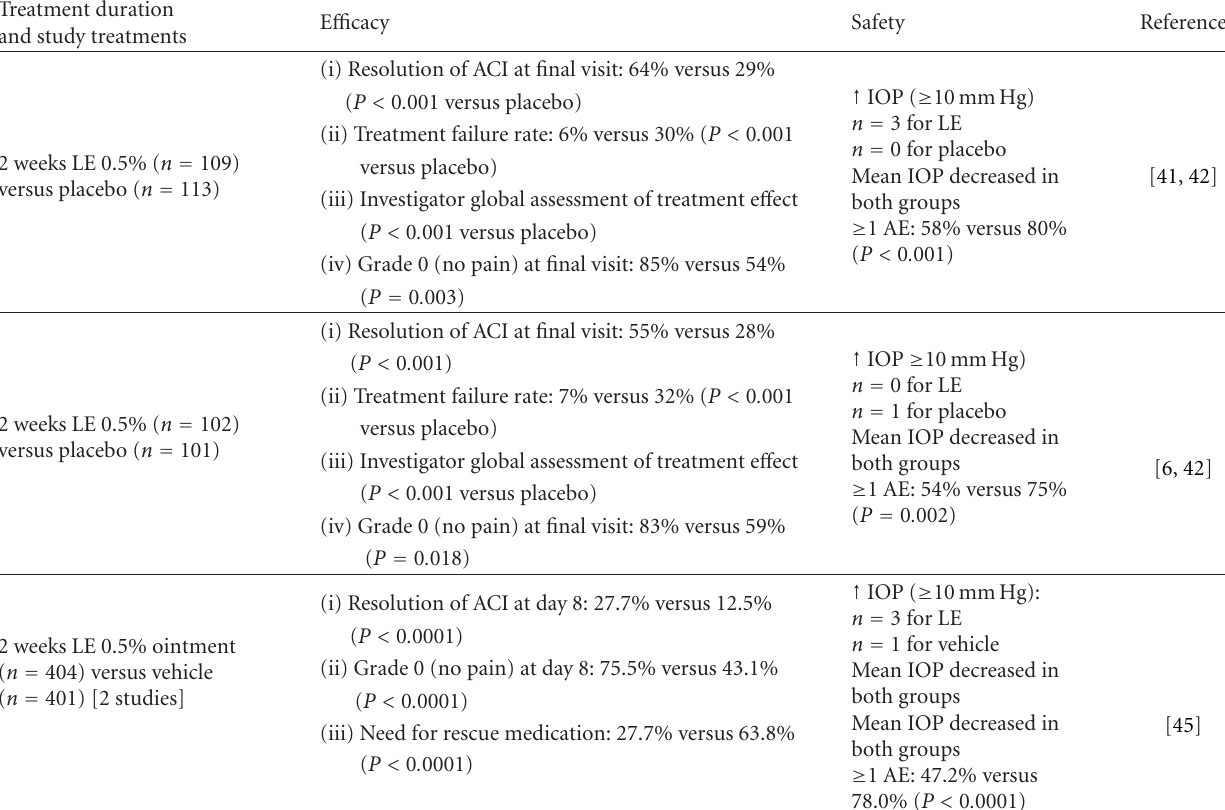
Table 2: Loteprednol etabonate: summary of randomized, controlled, clinical safety and e ffi cacy studies in postoperative inflammation. Treatment